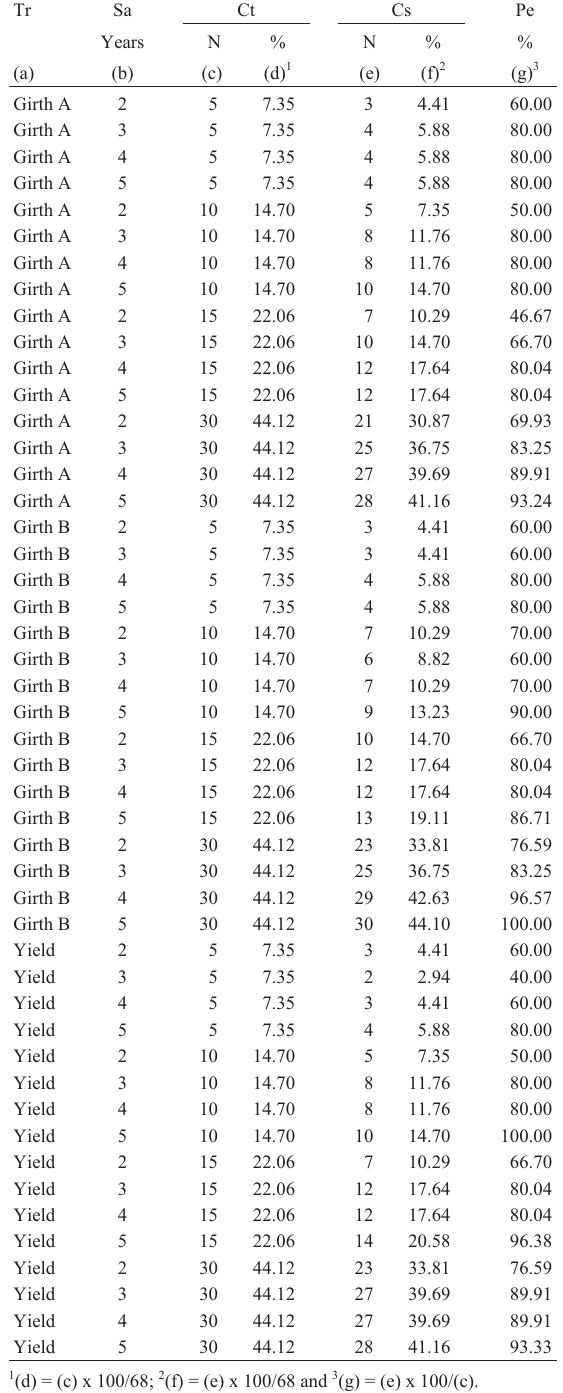
Table 4 - Extent of success in correctly selecting a set of 5, 10, 15 or 30 bestclonesforage6(girth)andage6(yield)bymakingselectionatage2, 3, 4, 5 or 6 respectively.